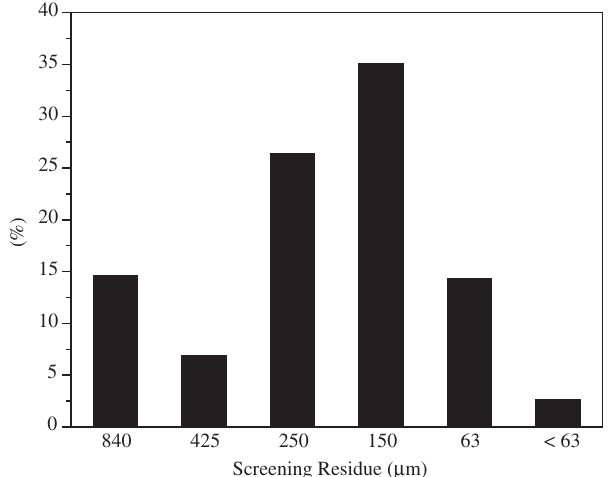
Figure 1. Granulated powder size distribution by sieving.